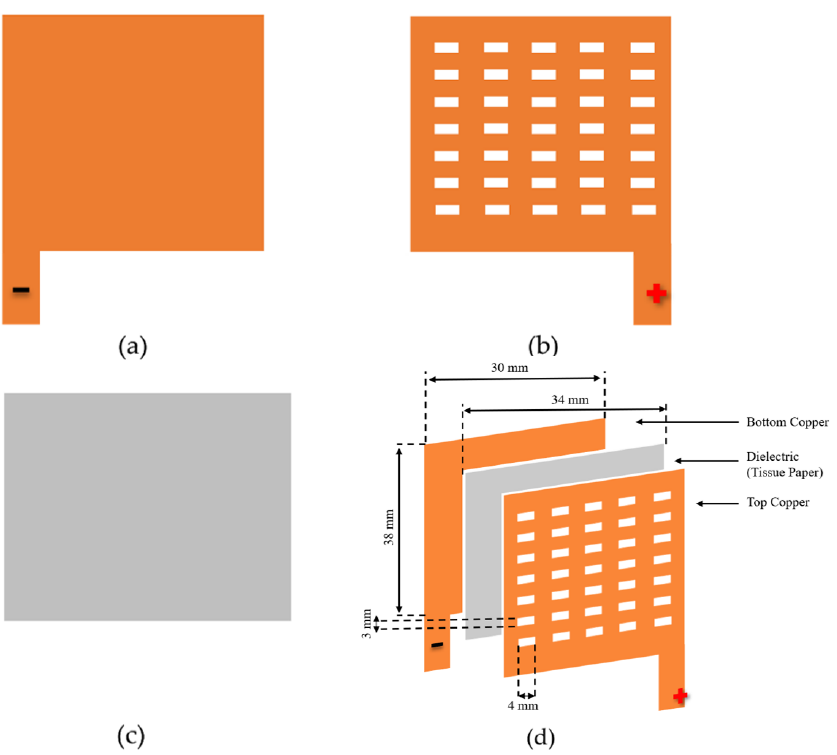
Figure 1. Copper-based, parallel-plate capacitive humidity sensor: ( a ) Lower side; ( b ) Upper side with meshes; ( c ) Tissue paper as a sensing layer; ( d ) Fabricated sensor.